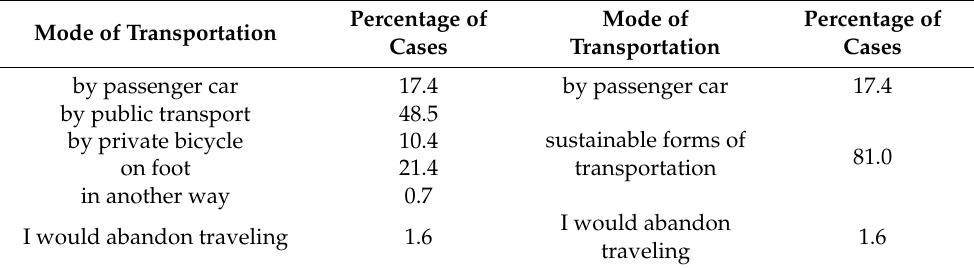
Table 4. If for some reason you would not be able to travel by a MEVO municipal bike today (e.g., no bike at the start station or system failure), how would you travel to your destination? ( n = 500).